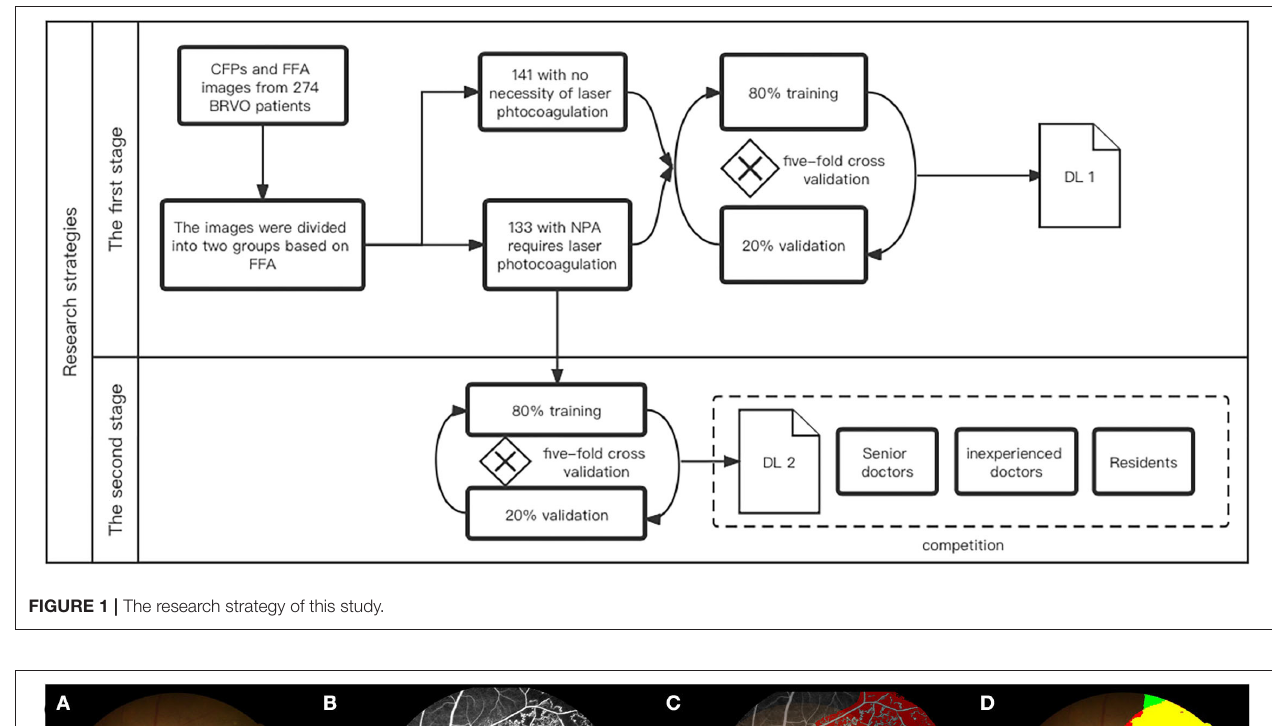
FIGURE 1 | The research strategy of this study.